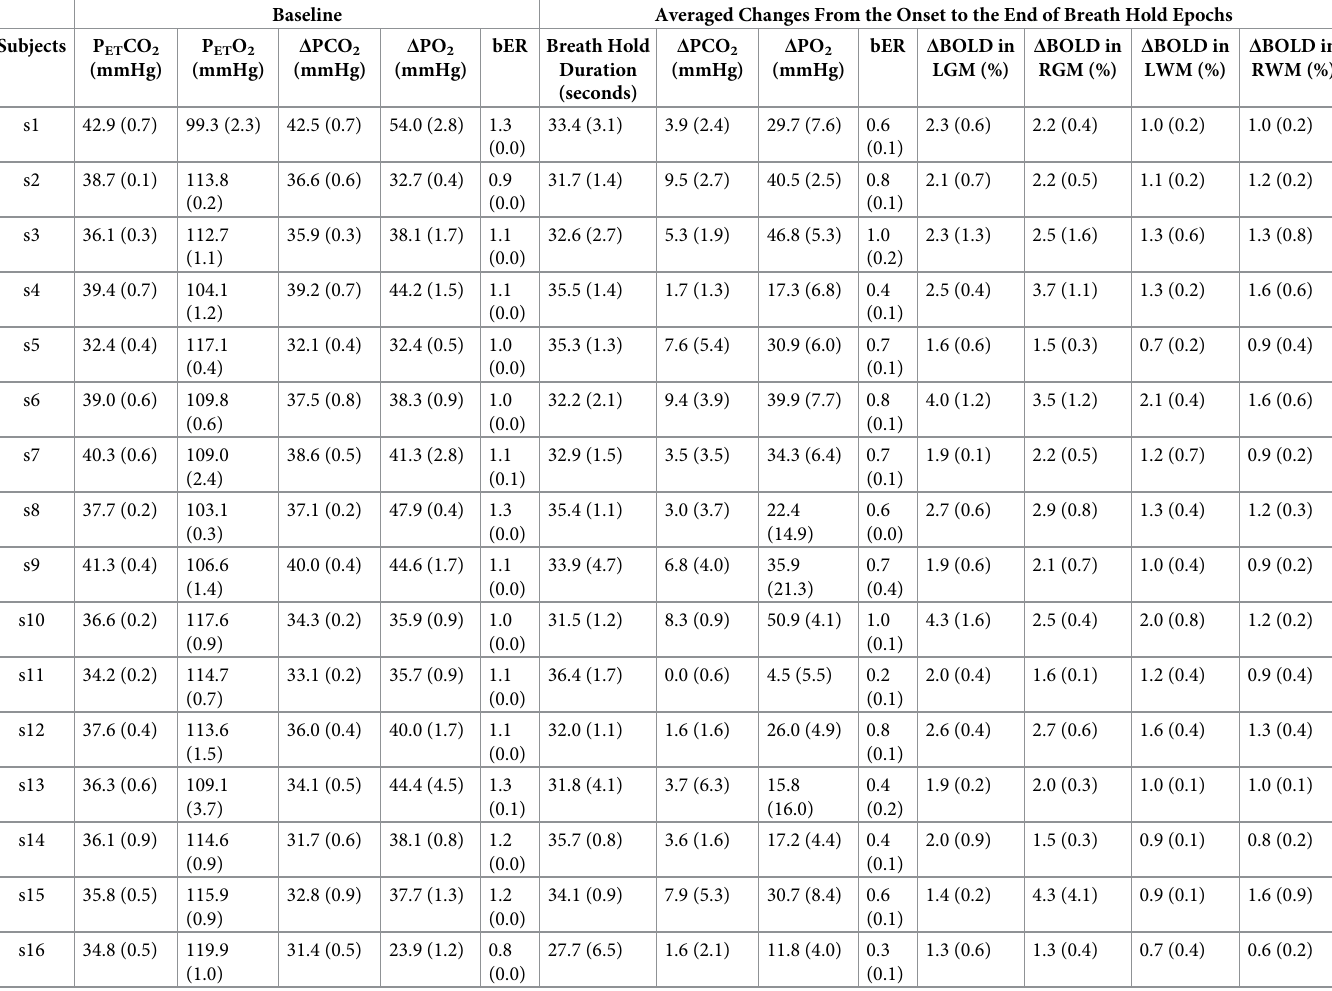
Table 3. RGE metrics and Δ BOLD in MRI sessions. Baseline Averaged Changes From the Onset to the End of Breath Hold